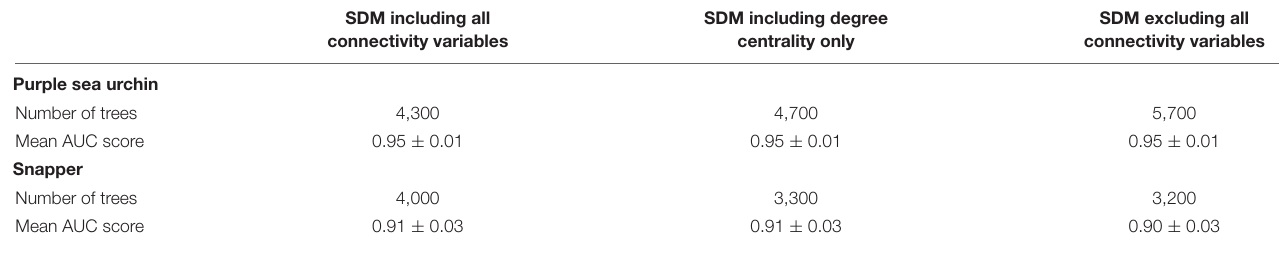
TABLE 2 | Optimal SDMs models results for each